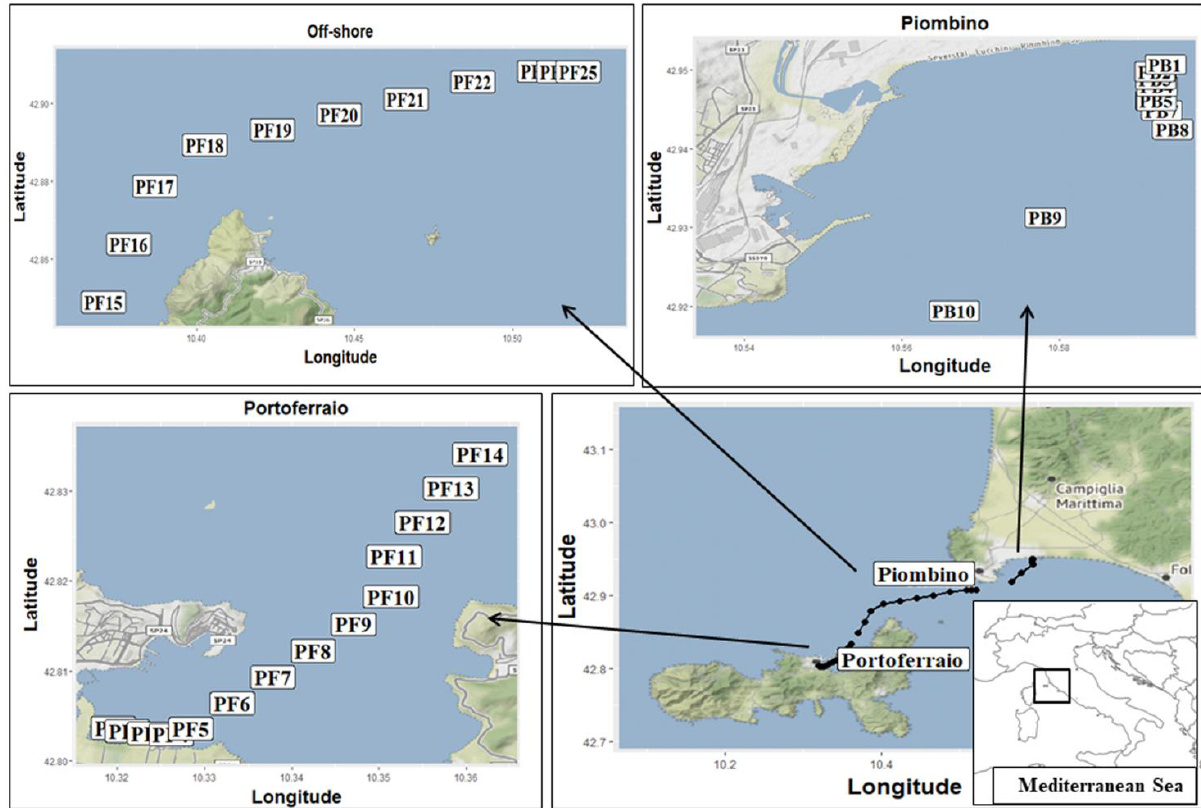
Figure 1. Map with the location of the Piombinochannel, and the three study areas along the seaway (Piombino, PB1-10, Portoferraio, PF1-14, and offshore, PF15-25).